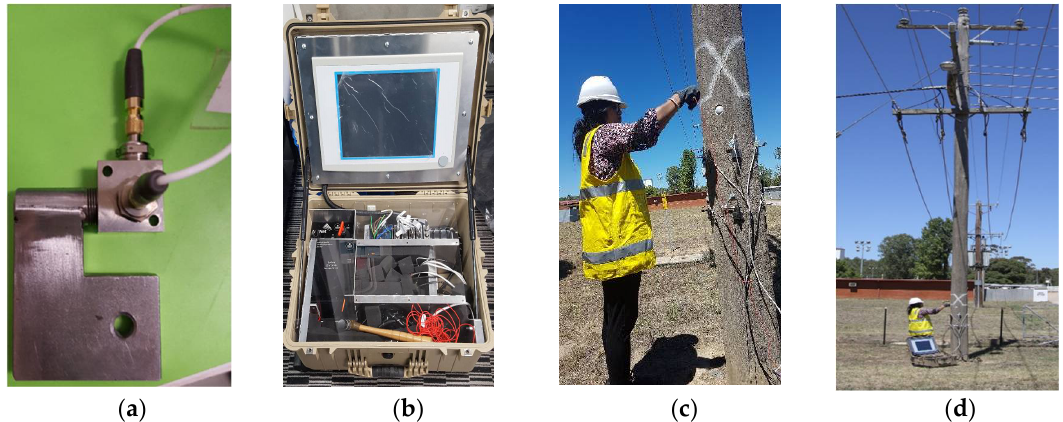
Figure 6. ( a ) Accelerometer attachment ( b ) Pole tester ( c ) Accelerometer arrangement ( d ) Field testing. Figure 6. (a) Accelerometer attachment (b) Pole tester (c) Accelerometer arrangement (d) Field testing